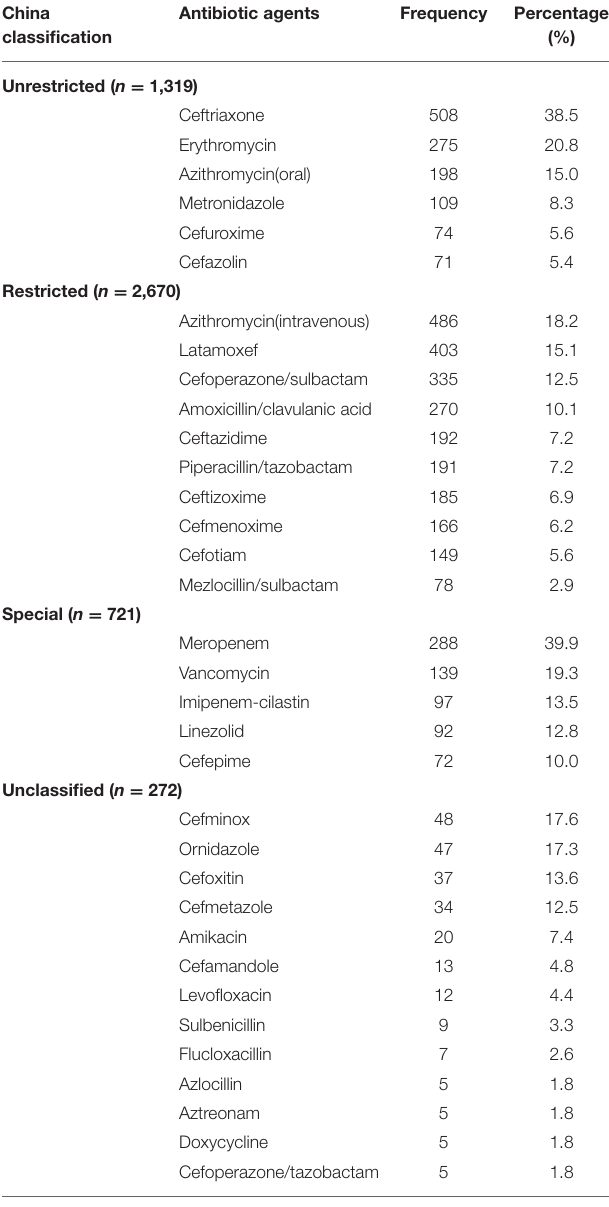
TABLE 5 | 4,982 antibiotics (China classification) prescribed to Chinese children by drug utilization 90% in 2017–2019. China